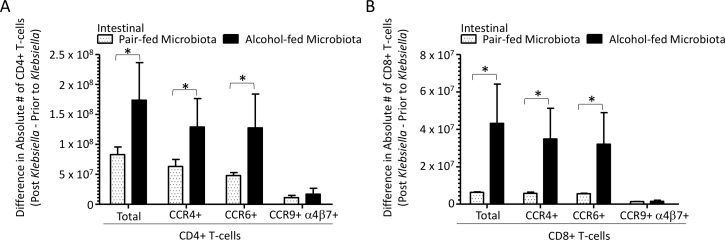
Alcohol-associated dysbiosis increases intestinal T-cell sequestration in mice.(A) Difference in absolute number of homing receptor positive intestinal CD4+ T-cells isolated 48 hrs. post-Klebsiella infection from values obtained pre-infection in alcohol-dysbiosis and pair-fed recolonized mice. (B) Difference in absolute number of homing receptor positive intestinal CD8+ T-cells 48 hrs. post-Klebsiella infection from values obtained pre-infection in alcohol-dysbiosis and pair-fed recolonized mice. Bars represent the mean of the cell counts post infection minus the cell counts prior to infection ± SEM, * indicates P < 0.05, by ANOVA with Dunn’s correction. N = 10/group.